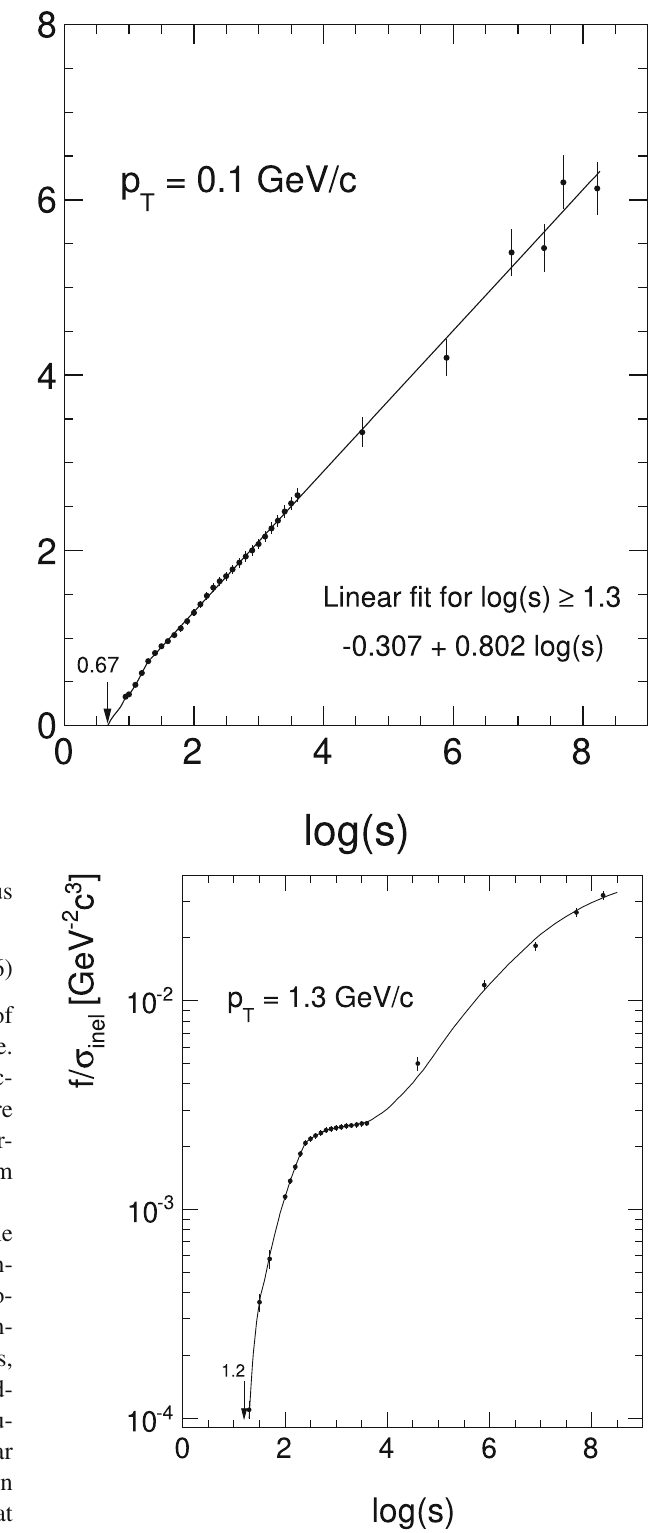
Fig. 130 f /σ inel at p T = 1.3 GeV/c as a function of log ( s